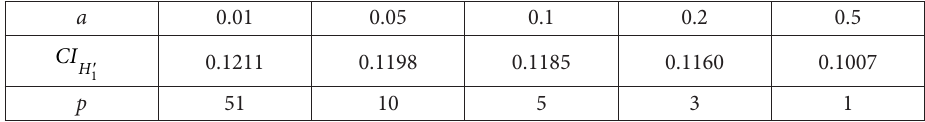
Table 2. The values